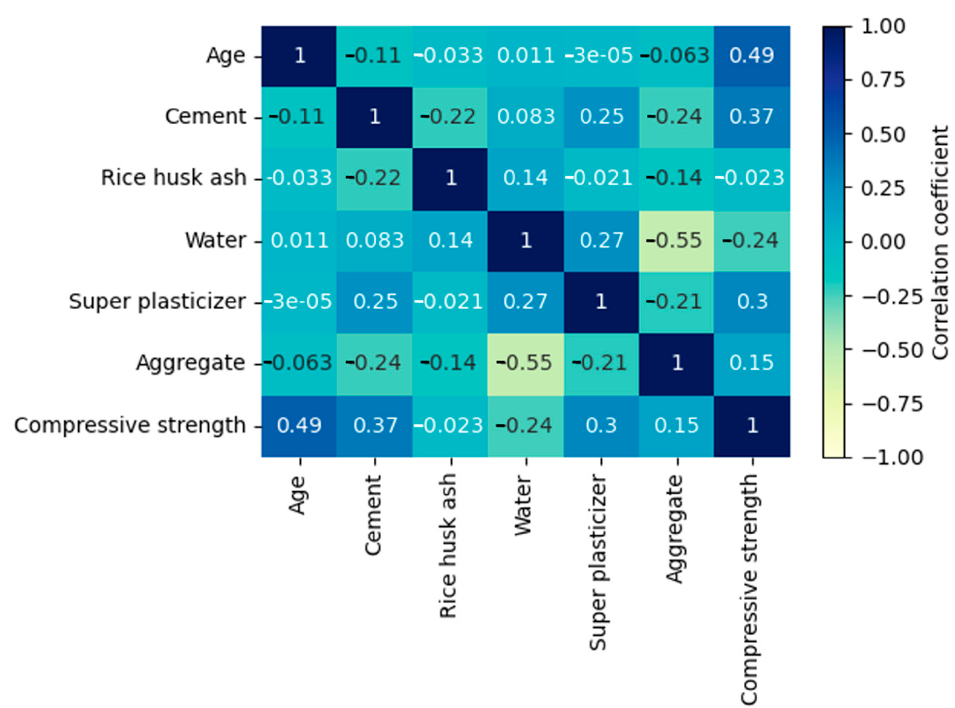
Figure 2. Correlation coefficient matrix of each variable in the RHA dataset.